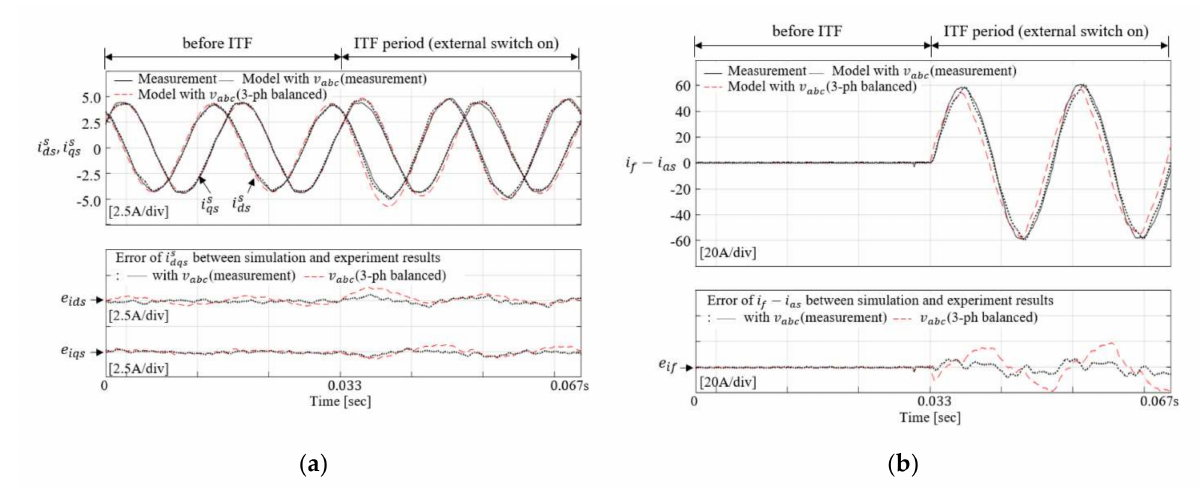
Figure 7. Simulation and experiment results in transient state of the ITF: ( a ) the D, Q-axis currents i s , i s qs and error of i s and i s qs between simulation and experiment and ( b ) the fault resistor current ds ds i f − i as , and error of i f − i as between -simulation and experiment before ITF and during ITF period.